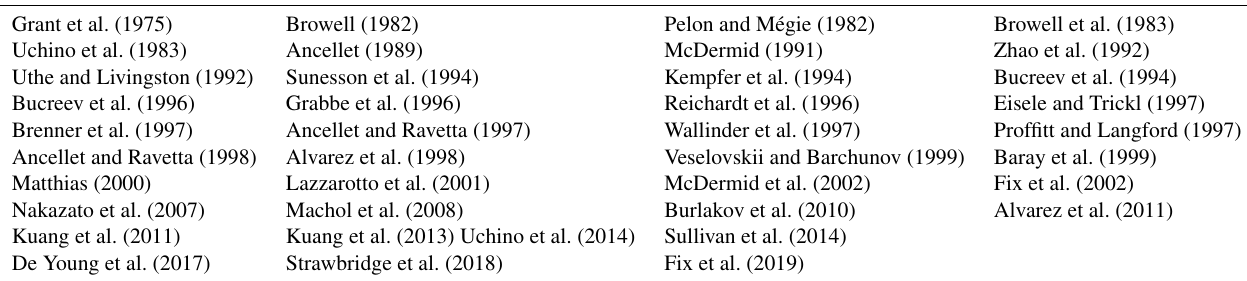
Table A3. List of citations for papers describing ozone DIAL